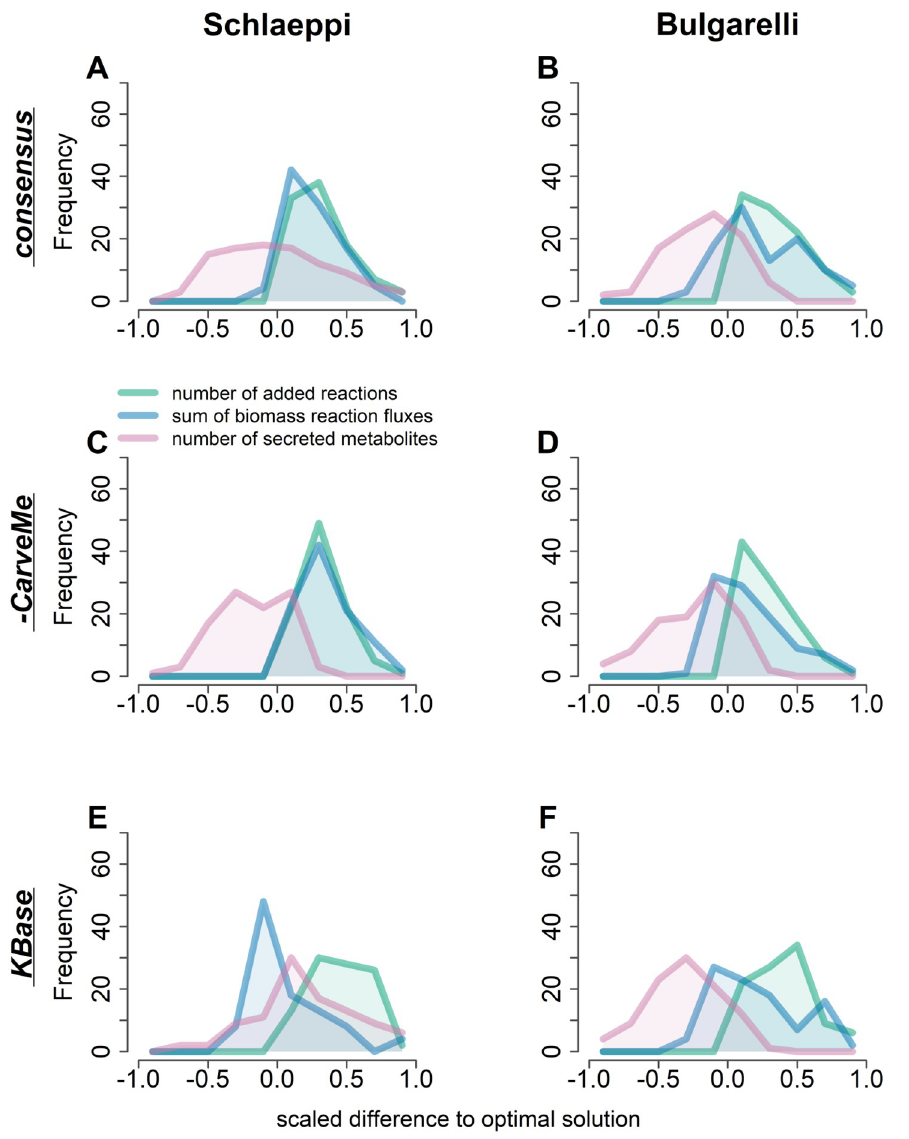
Fig 3. Differences in gap-filled reconstructions across the random orderings of isolates. The number of added reactions, sum of biomass fluxes, and the total number of secreted metabolites by the gap-filled reconstructions were compared between all orderings explored by COMM I T. (A,B) consensus reconstructions from all approaches (C,D) consensus reconstructions without CarveMe draft reconstructions (E,F) converted KBase draft reconstructions. Results for the Schlaeppi community are shown on the left and results from the Bulgarelli community on the right panels. The lines represent the number of counts for each histogram bin, for the added reactions, growth rates, and numbers of exchanged metabolites. The values for each measure were scaled to the respective value associated with the optimal ordering. Number of iterations: n = 100; Number of recovered isolates per community: 24 for Schlaeppi and 20 for